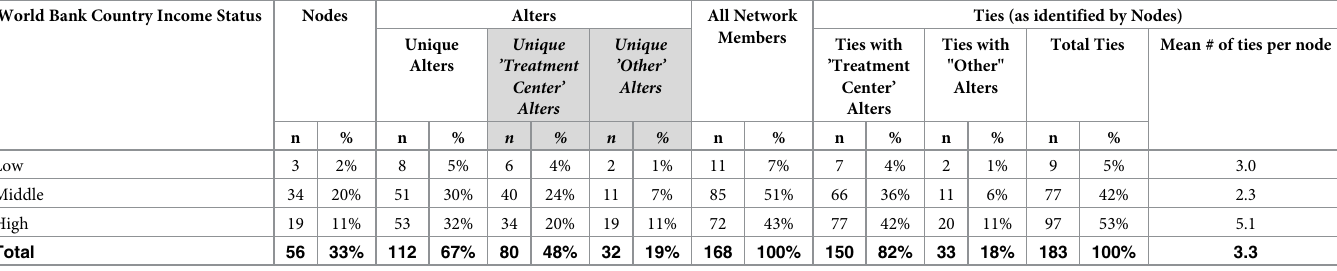
The 56 egos collectively identified 183 collaborations (Table 1). Collaborations between retino- blastoma treatment centers accounted for 82% (150/183). Only 14 (8%) indicated there was a Memorandum of Understanding (MoU) established to govern the relationship; 1 indicated there was none (1%); and 168 (92%) declined to answer. The mean number of alters identified per ego was 3.3 (Table 1). North American nodes identified the highest mean alters per ego at 6.8, while Middle Eastern and North African egos reported the least, at 1 (Table 1). Nodes in HICs had the highest mean alters per ego at 5.1, fol- lowed by 3.0 in low-income countries (LICs) and 2.3 in MICs (Table 2). A network diagram was generated based on these findings, depicting 9 distinct groups: one large ( > 10 nodes) interconnected group, with representation from all geographic regions and income settings; five small ( < 10 nodes) groups, consisting of nodes/alters from 1–4 geographic Table 2. Nodes, alters and ties by World Bank Country income status.